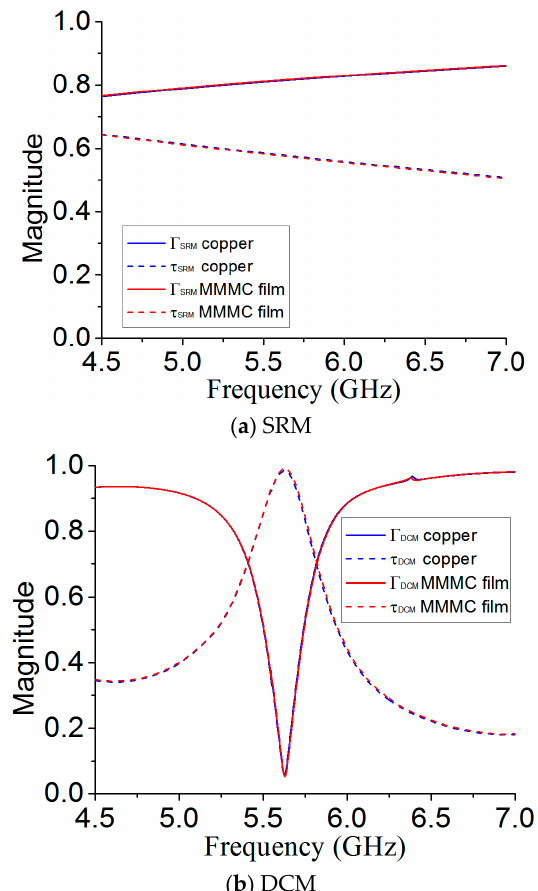
Figure 9. Performances comparison of MS between using MMMC film and copper.